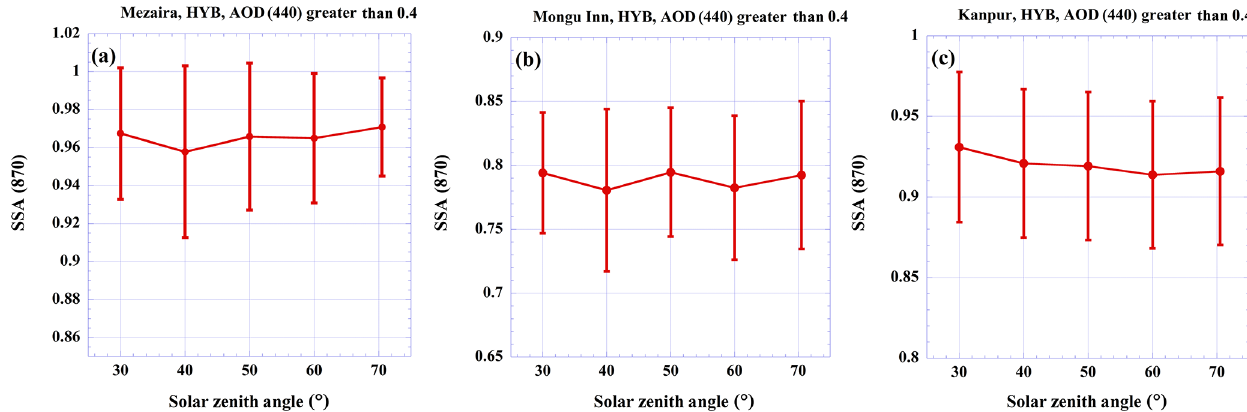
Figure 15. Dependence of 870nm SSA hybrid scan retrievals on SZA for three AERONET sites: (a) Mezaira, (b) Mongu Inn, (c) Kanpur.